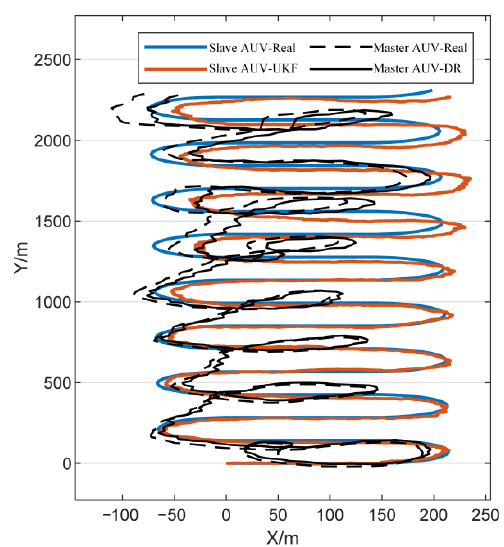
Figure 19. Paths of master and slave AUVs based on UKF.